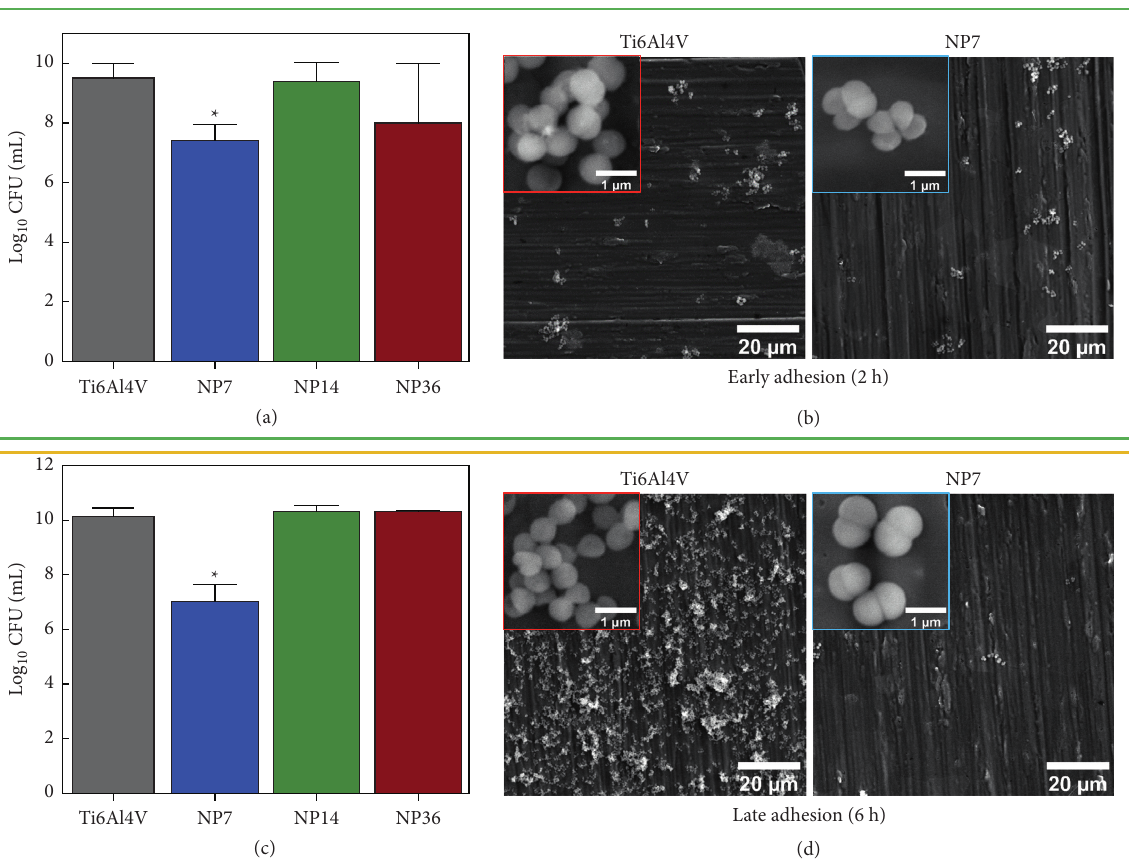
Figure 3: Antibacterial behavior on the experimental materials. (a) Bacterial viability after 2 h of incubation. (b) S. aureus morphology on the control and NP7 material at early adhesion phase. (c) S. aureus growing viability after 6h. (d) S. aureus phenotype characterization at the late adhesion. The symbol ∗ shows significant cell viable differences between the material